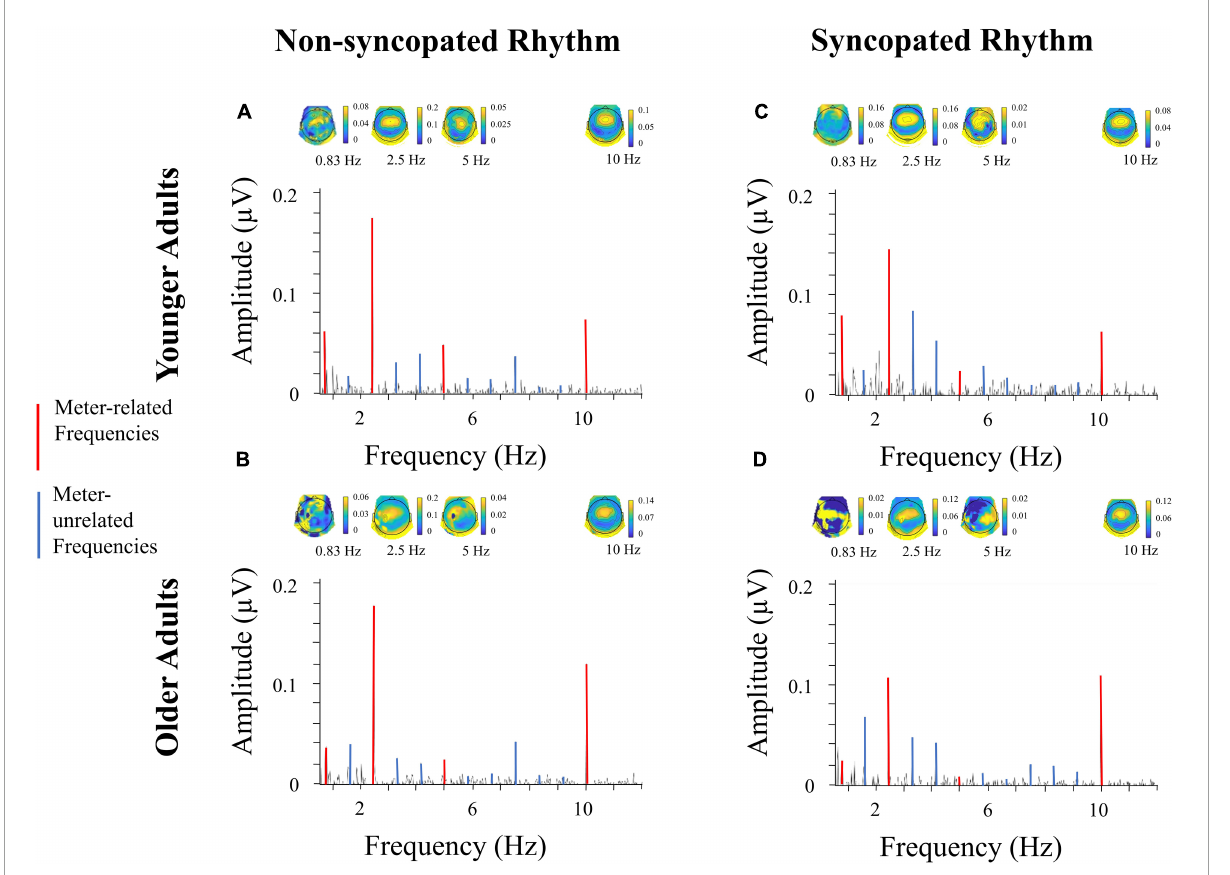
FIGURE4 Electroencephalography (EEG) spectra, fast tempo. Amplitude of neural activity at electrode Cz ranging from 0.9Hz to 12Hz for younger adults (A,C) and older adults (B,D) for non-syncopated (A,B) and syncopated (C,D) rhythms for fast tempo , along with topographic maps corresponding to each meter frequency. Frequency and amplitude scales are identical across conditions and groups to allow direct comparison across spectra. The scales of the topographical maps are adjusted for each condition, group and frequency for optimal visualization of topographical distribution across the EEG channels. Each topographical map corresponds to a meter-related frequency, shown in